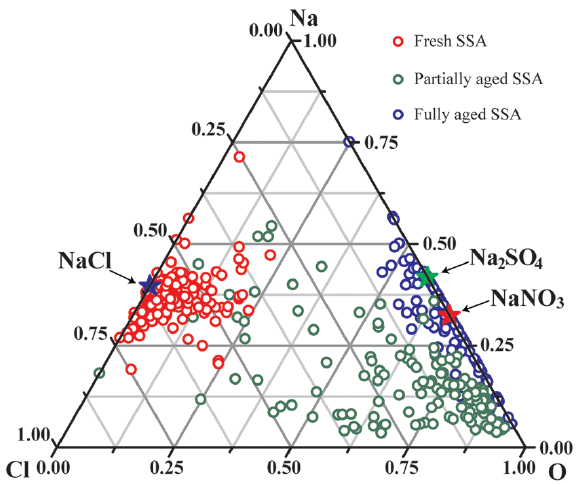
Figure 5. Triangular diagram of Na–Cl–O showing EDX data of the elemental composition of 405 SSA particles. The three stars repre- sent the elemental composition of pure NaCl, Na 2 SO 4 , and NaNO 3 , respectively.